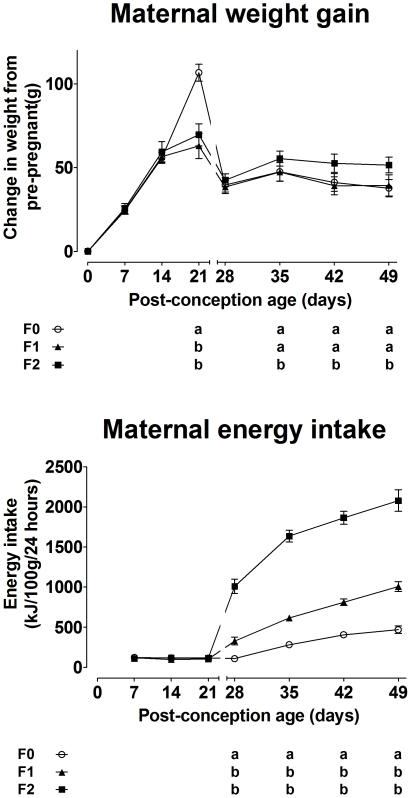
Change in maternal body weight from conception and energy intake during pregnancy and lactation.Values are mean ± SD for n = 5−7 rats per group. Different letters indicate significantly different (P<0.05) values between generations.